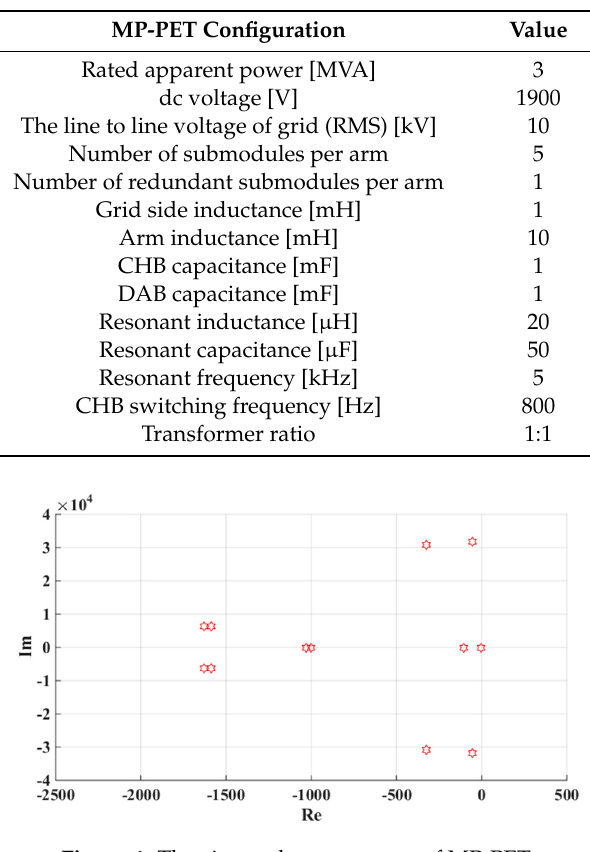
Figure 4. The eigenvalues spectrum of MP-PET.